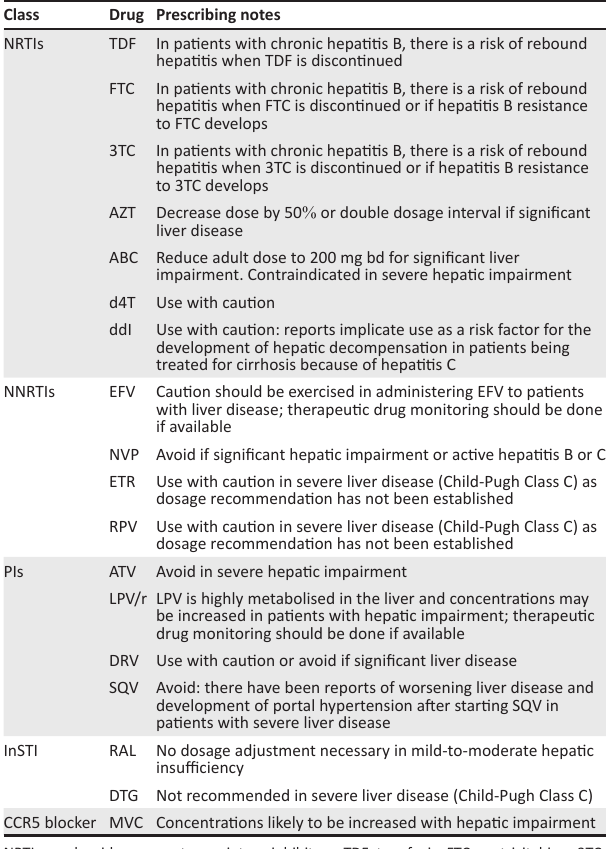
TABLE 12: Prescribing antiretrovirals in liver